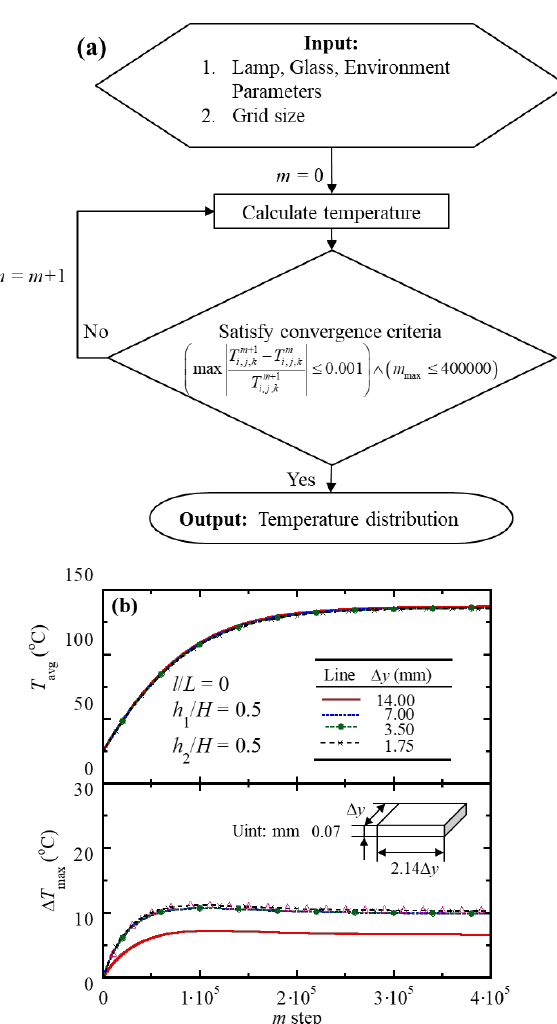
Figure 5. ( a ) Flow chart of program for modeling; ( b ) Results of grid convergence verification.